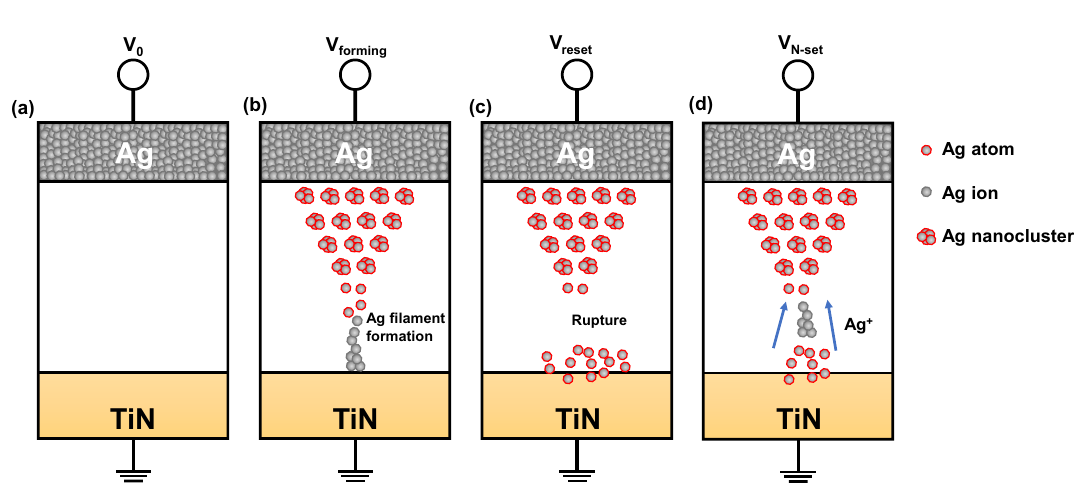
Figure 2. ( a ) Typical I–V characteristics of the Ag/ZnO/TiN device. ( b ) Endurance testing involving 1000 cycles. ( c ) Cumulative probability of HRS and LRS with a read voltage of 0.1 V.